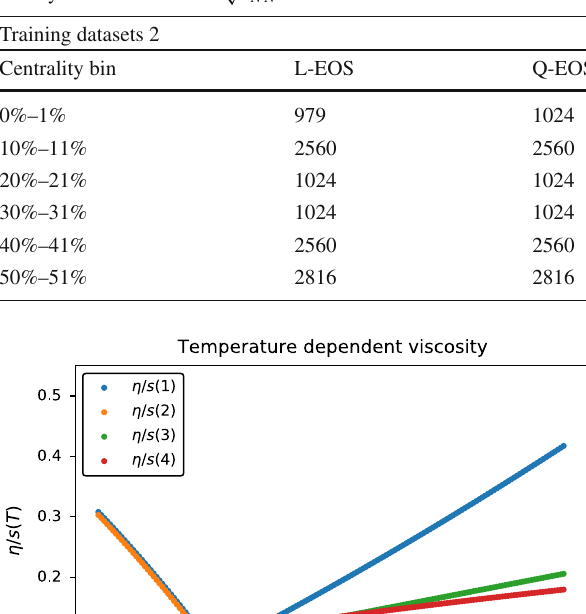
Table 2 Training datasets 2: numbers of event-by-event spectra ρ( p ,(cid:6)) computed by the iEBE-VISHNU hybrid model with the MC- T Glauber initial conditions in the centrality range 0–60%. The ratio of shear viscosity to entropy density η/ s = 0 . 00. The equilibration time τ = 0 . 4 fm / c. The switching temperature T 0